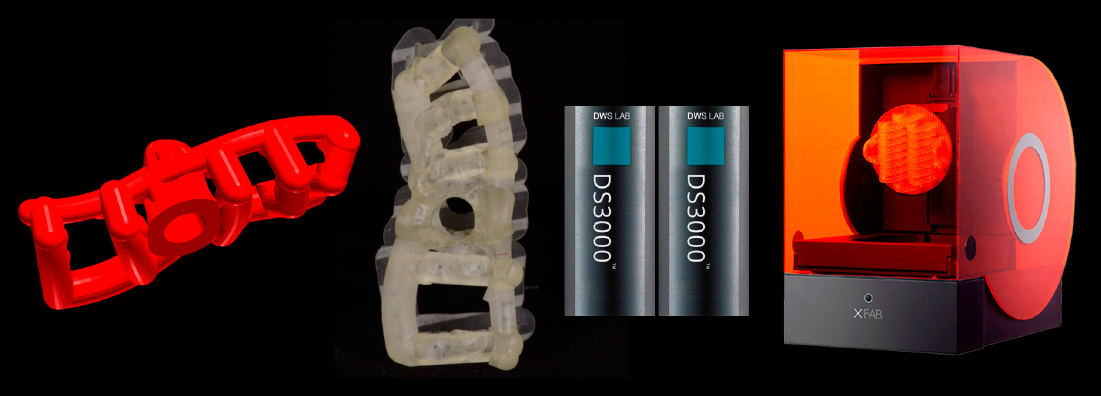
Figure 5. The open selective tooth-supported surgical template is printed with the XFAB2000 SLA printer (XFAB2000 ® , DWS, Thiene, Italy) using the DS3000 ® resin.